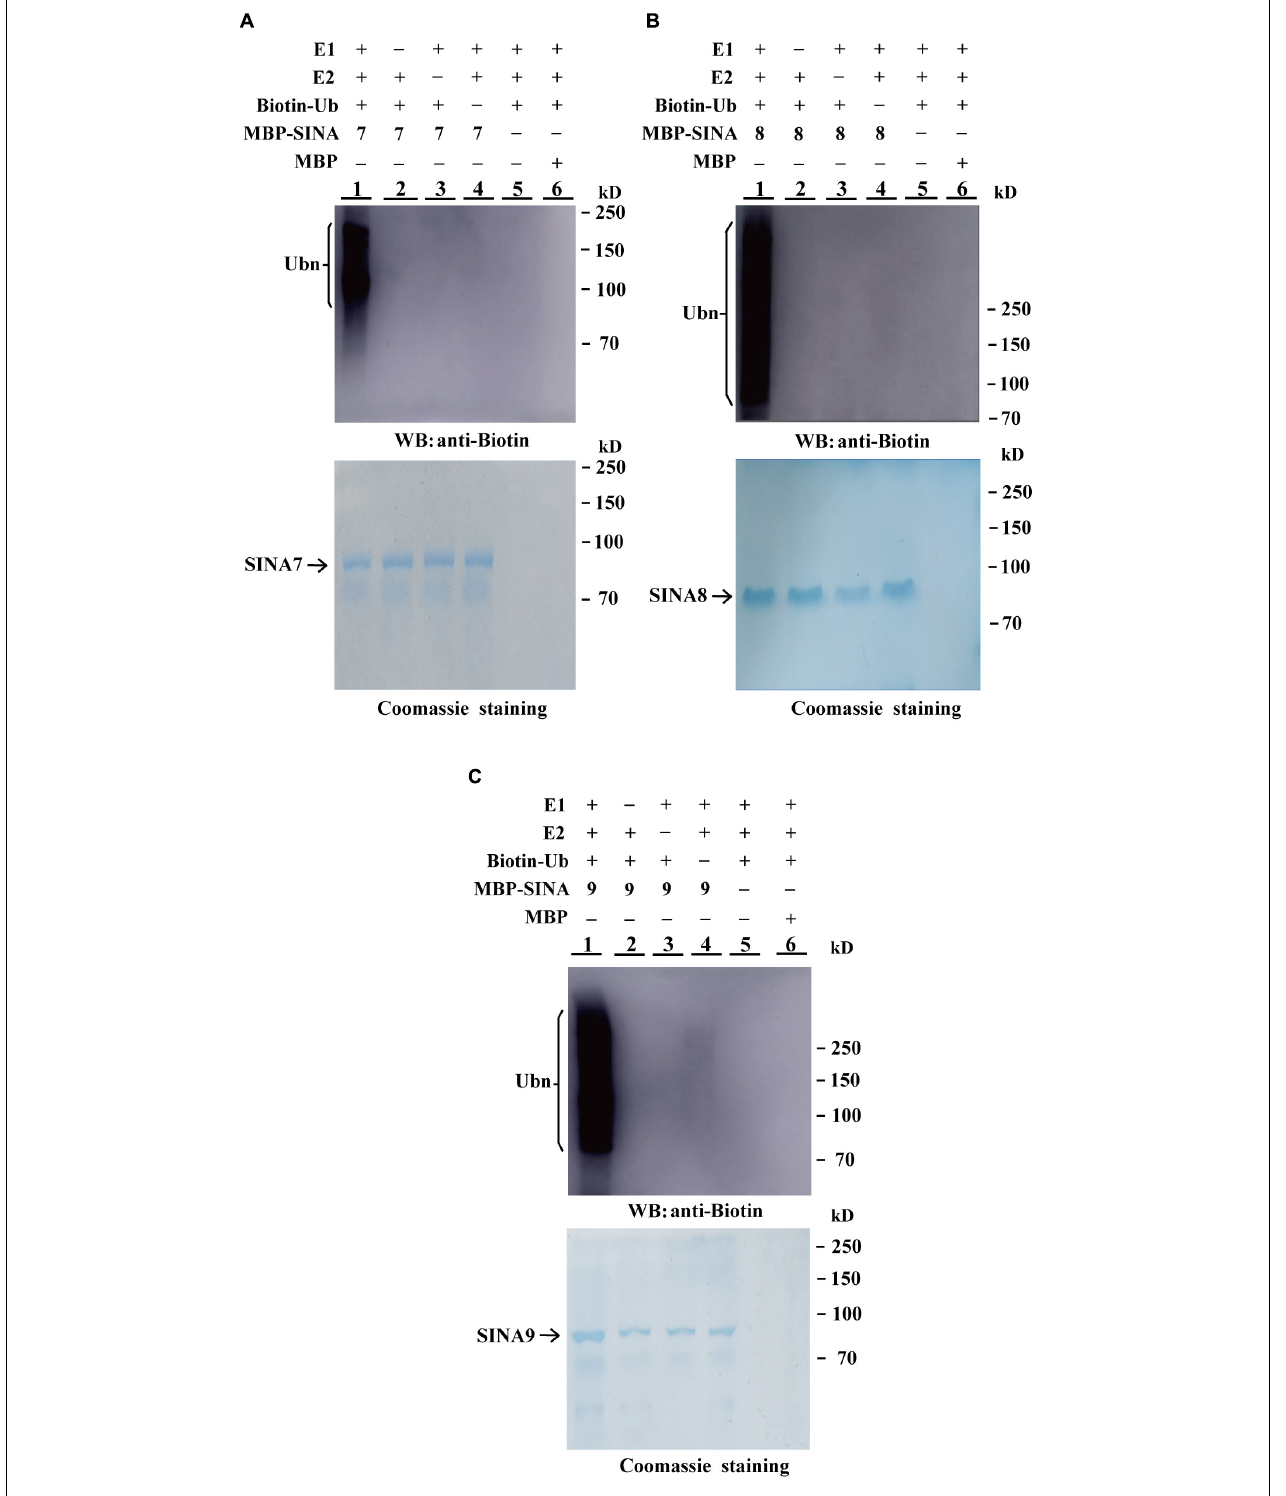
FIGURE 3 | In vitro ubiquitination assays of GhSINA7, GhSINA8, and GhSINA9 proteins. (A–C) The E3 ubiquitin ligase activities of MBP-SINA7 (A) -SINA8 (B) and -SNA9 (C) fusion proteins were determined in the presence of E1, E2, and biotinylated ubiquitin (Bt-Ub) (Lane 1). Samples were resolved by 7.5% SDS-PAGE and determined by western blotting (WB) with an anti-biotin antibody. MBP was used as a negative control. Coomassie brilliant blue staining indicates equal amounts of SINA3 present in the reactions.